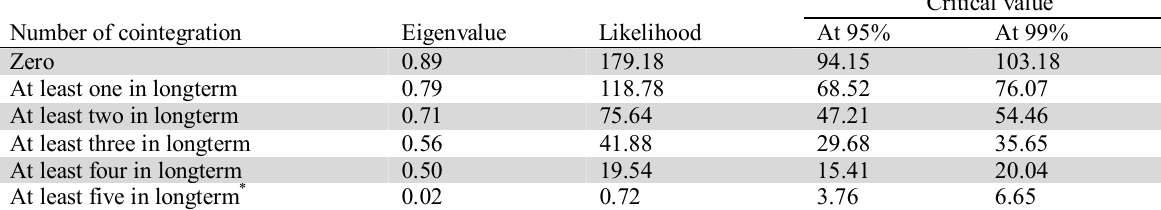
The summary of Johansen’s cointegration test for Industrial sector